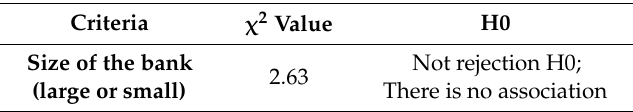
Table 2. Results of efficiency1 related to the size of